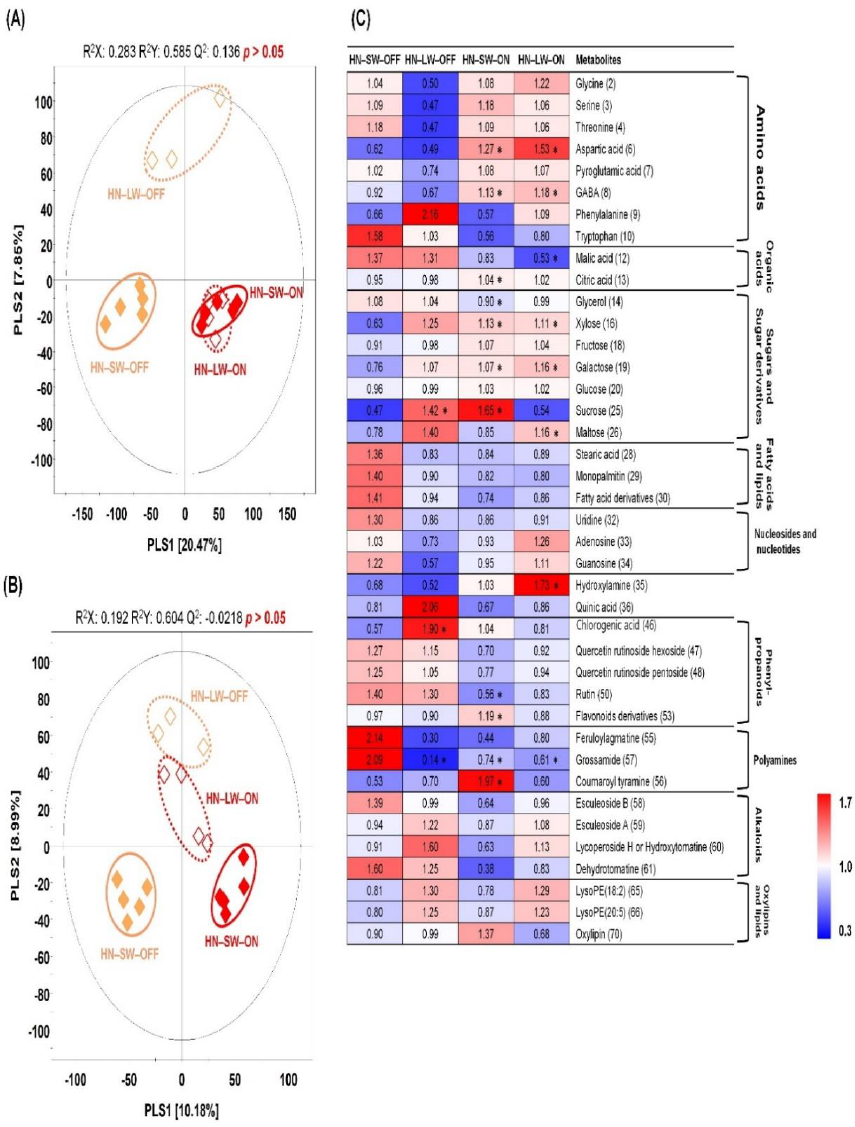
Figure 4. PLS-DA score plots from GC-TOF-MS ( A ) and UHPLC-LTQ-Orbitrap-MS ( B ) analysis of tomato cultivated under different water and light condition for high N soil. Symbol, HN-SW-OFF ( ◆ ); HN-LW-OFF ( ◇ ); HN-SW-ON ( ◆ ); HN-LW-ON ( ◇ ). HN, high N; SW, sufficient water; OFF, red light off; LW, limited water; ON, red light on. Heat map analysis for the relative abundance of discriminant metabolites (VIP > 1.0) based on GC-TOF-MS and UHPLC-LTQ-Orbitrap-MS datasets ( C ). The colored squares (blue to red) indicate fold changes normalized by the average of each metabolite. * Significantly difference metabolite from control (HN-SW-OFF) evaluated by t -test ( p < 0.05).